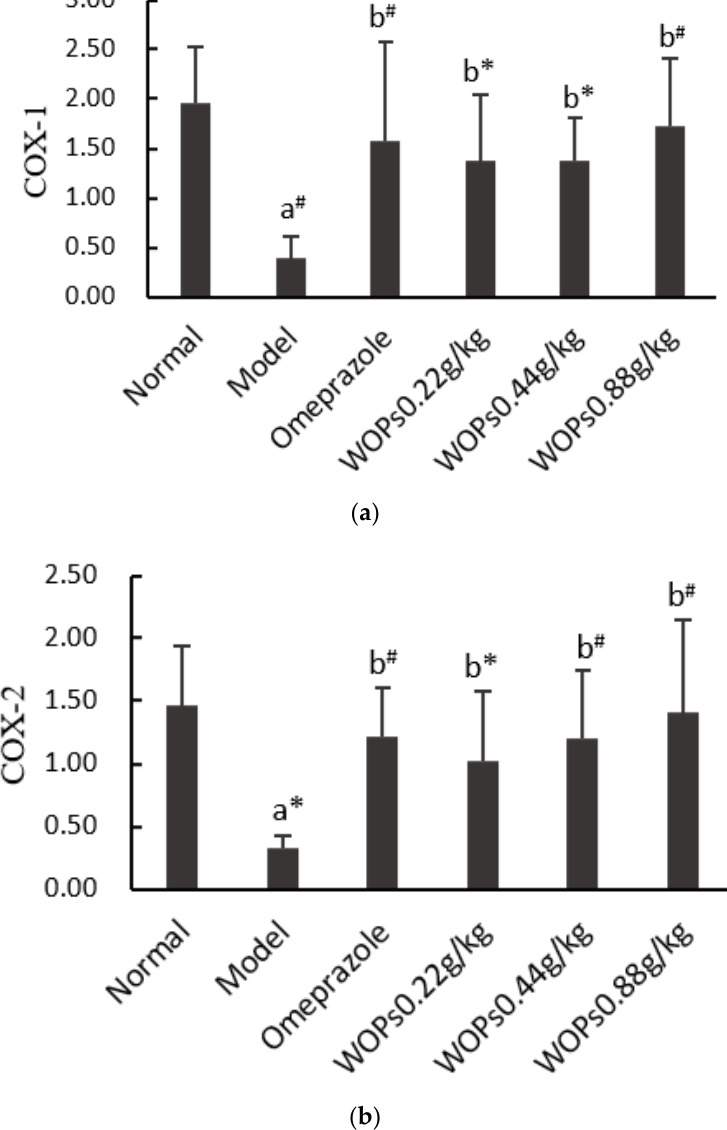
Figure 7. Effects of WOPs on the RNA expression of COX-1 ( a ) and COX-2 ( b ) in gastric tissue. Significance was represented as * p < 0.05, # p < 0.01; a—comparison with the normal group, b—comparison with the model group; 6 per group. COX—cyclooxygenase; WOPs—walnut oligopeptides.